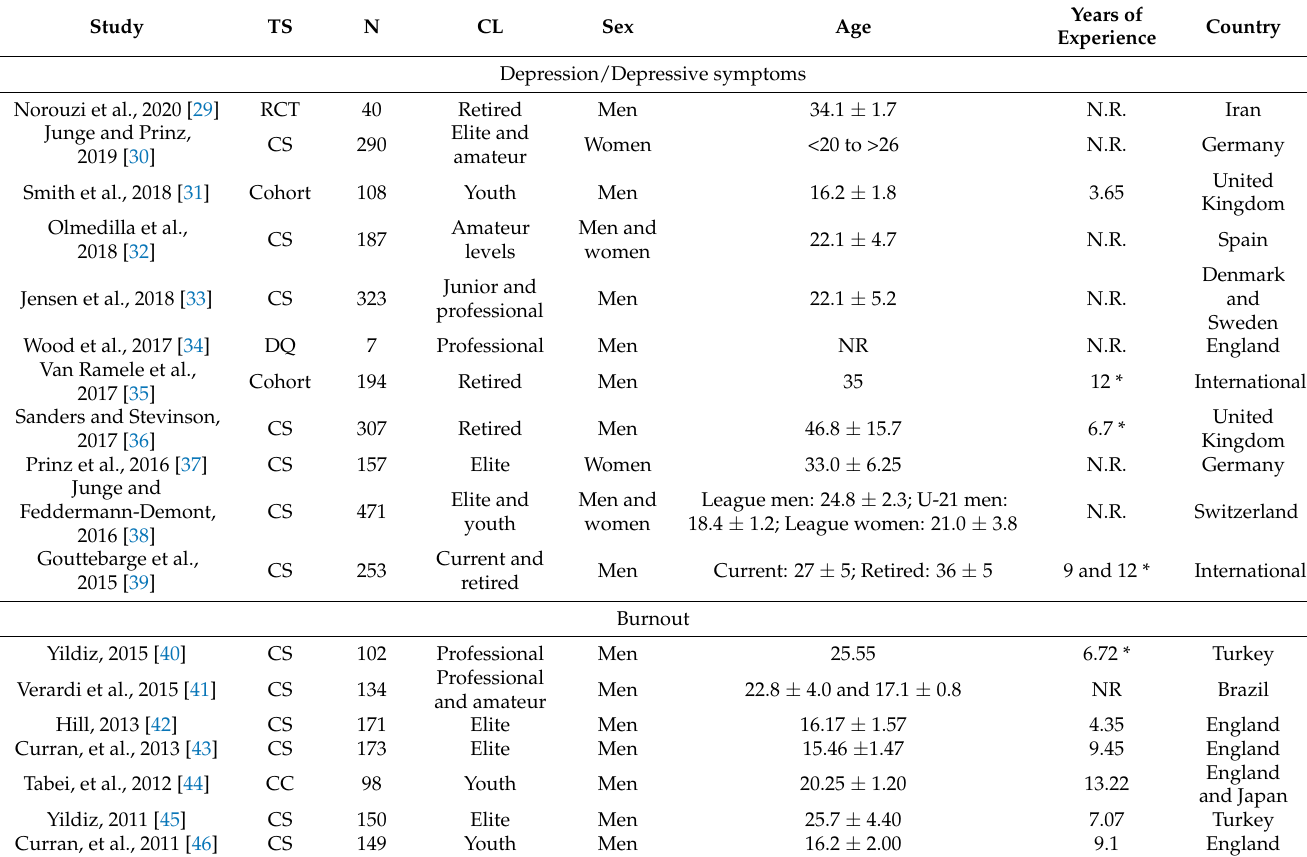
Table 2. Characterization of the included